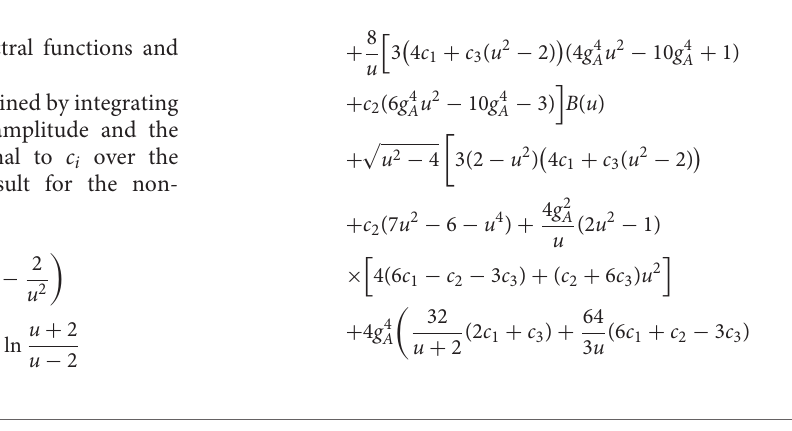
FIGURE 4 | N 4 LO 2 π -exchange contributions to the NN interaction. The same notation as in Figure 3 is used. Open circles with a large solid dot inside refers to the 1 / M N corrections to vertexes with two derivatives. Solid triangles represent vertices with index 1 i dark-shaded oval. Adapted figure with permission from Entem et al. [46], copyright (2015) by the American Physical Society. (A,B) Two-loop diagrams, and (C) relativistic corrections to one loop